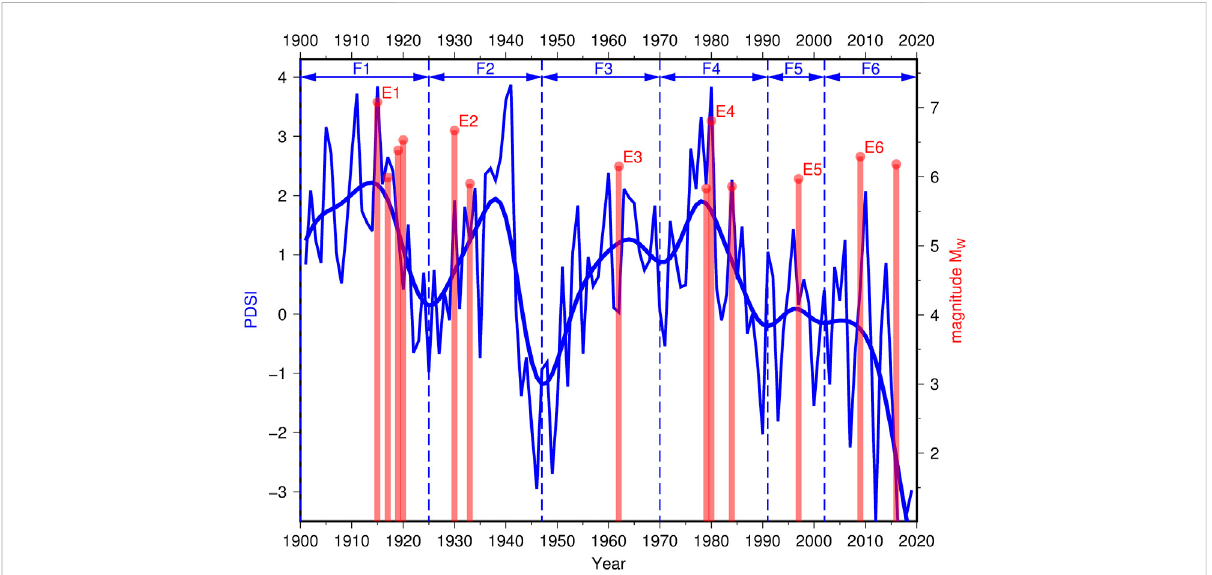
FIGURE 2 Relationship between the occurrence of M ≥ 5.8 earthquakes (red bars with the height proportional to the magnitude) and the evolution of the scPDSI (thin blue line) in the Apennines since 1901. The thick blue line is the smoothed version of the scPDSI obtained by kernel regression for a smoothing parameter h=3 years. The time periods F1 – F6 are those corresponding to the six long-term fl uctuations of the smoothed scPDSI. The earthquakes E1 – E6 are the strongest earthquakes in each of the time periods F1 –